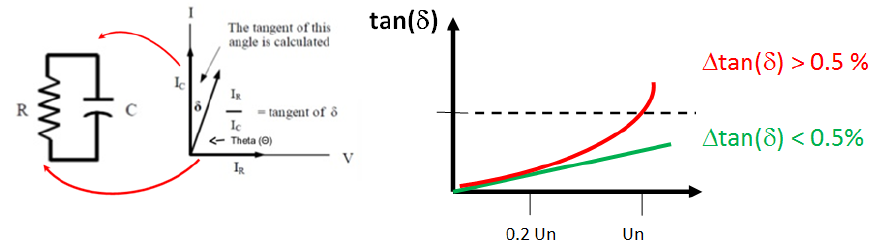
Figure 26. Measured tan( δ ) versus voltages shows in red a trend of curve out of the IEC 60034-27-3 acceptance criterion and in green, the trend of curve in accordance with the IEC 60034-27-3 acceptance criterion. In individual coil, according to IEC 60034-27-3, tan delta tip-up that is the difference between two predefined voltage steps of 0.6 Un and 0.2 Un (tan( δ ) 0.6 – tan( δ ) 0.2 ) shouldn’t exceed 0.005. In complete motor phase, there is not recommendation given by IEC standard, according to IEEE 286, usually Tip-Up is the difference between two predefined voltage steps of 0.25 Vn and Vn, with Vn the phase to ground voltage. When an excess of partial discharges is encountered at the highest voltage, the equivalent current Ir increases and tan( δ ) also increases. Such an issue is detected by the Tip-Up criterion.